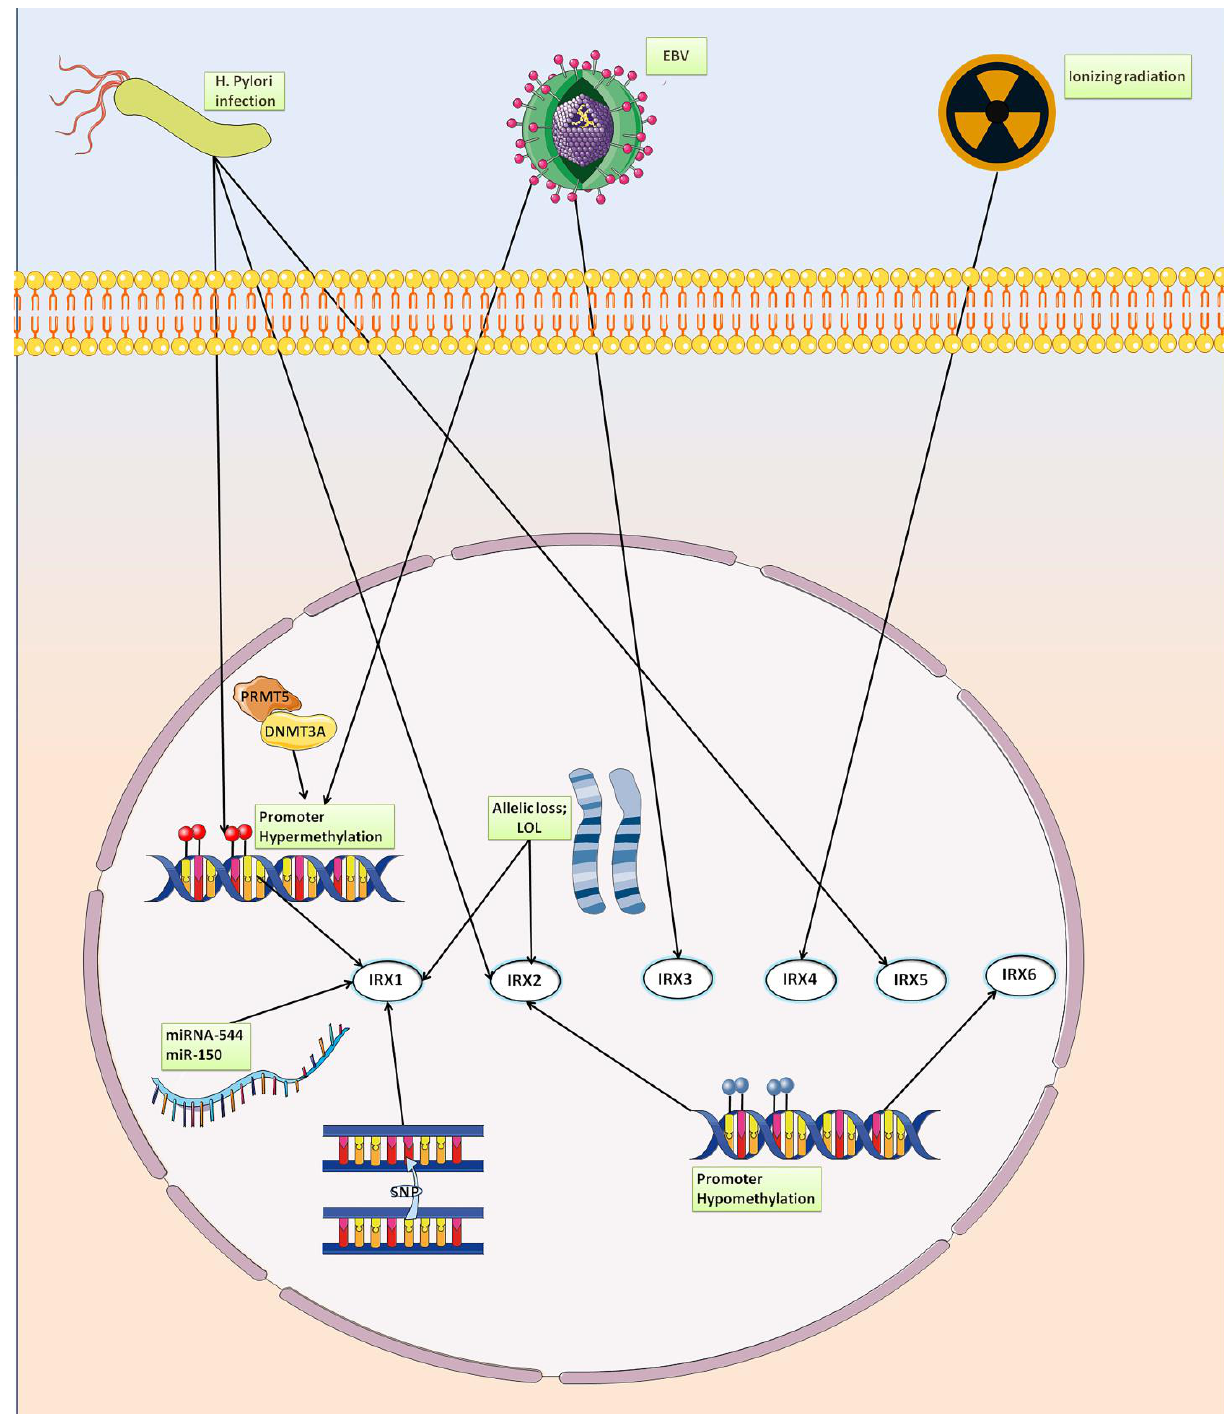
Figure 3. Mechanisms of Iroquois family gene regulation in GC.